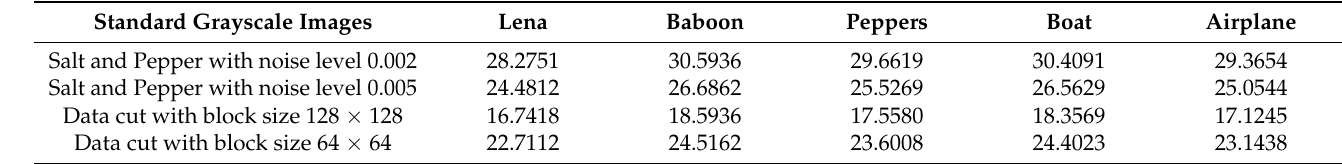
Table 8. Peak signal to noise ratio (PSNR) (dB.) values for noise and data cut attacks.